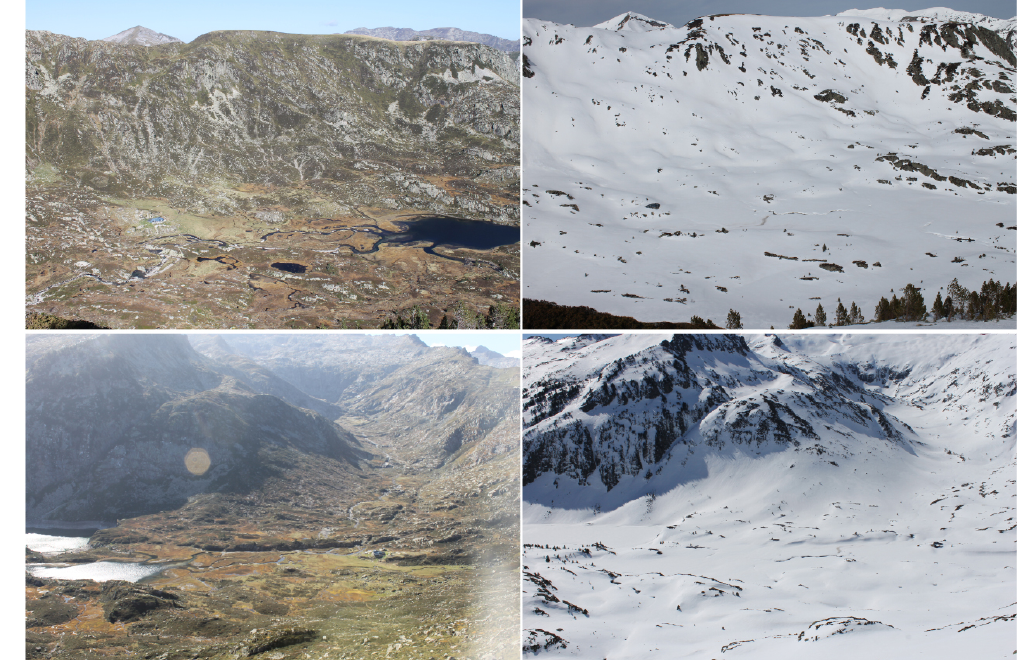
Figure 2. Comparison of terrestrial oblique pictures taken by an automatic camera (see Fig. 1 for localization). On the left, the pictures were taken on 26 October 2014. On the right, the pictures are from 10 March 2015. These photographs were taken at the same time of day as the Pléiades images taken on 11 March 2015